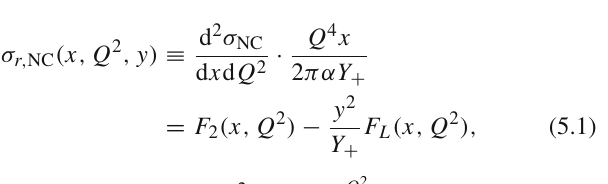
Fig. 19 Comparison of the gluon (left) and quark singlet (right) at Q 0 = 1 . 64 GeV between the NNPDF3.1sx NNLO+NLL x fits with the = 2 . 69 GeV 2 (baseline) and Q 2 = 3 . 49 GeV 2 kinematic cuts Q 2 min min